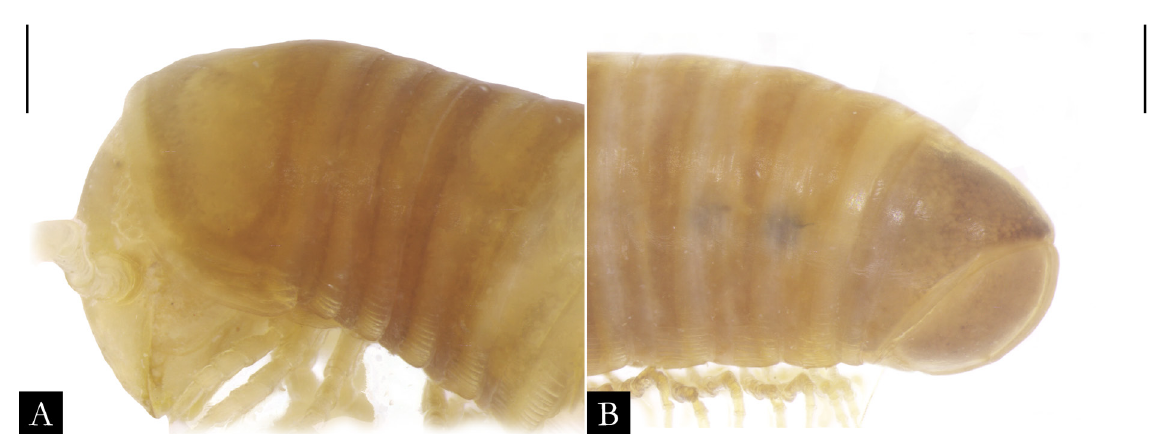
Fig. 78. Pseudonannolene leucocephalus Schubart, 1944, ♂ (MZSP 1060), in lateral view. A . Anterior region. B . Posterior region. Scale bars = 0.5